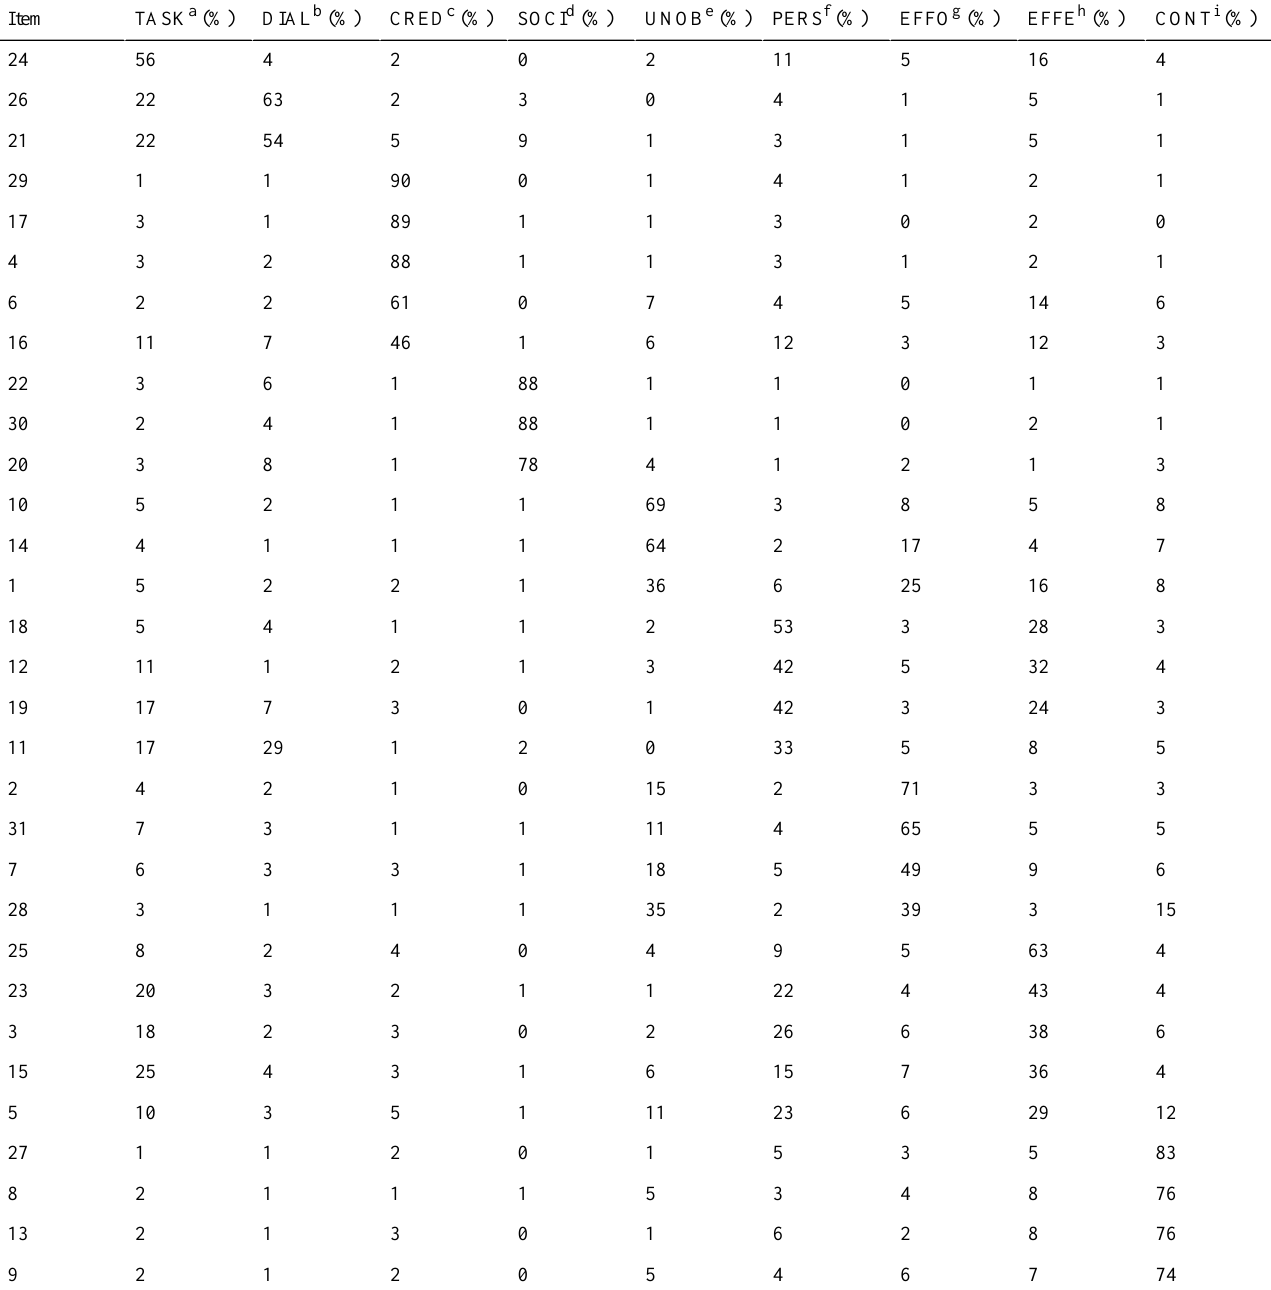
Table 5. Popular placement